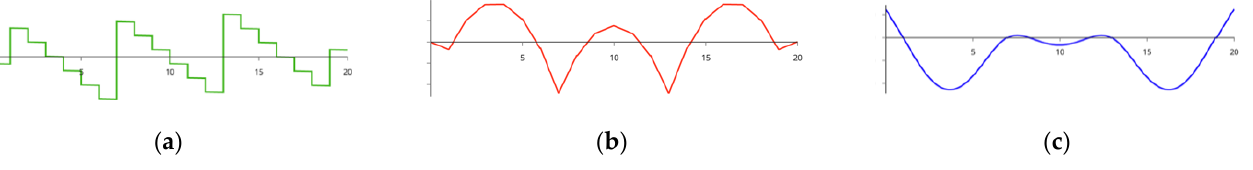
Figure A8. Two-span beam ( a ) shear force diagram, ( b ) bending moment diagram, and ( c ) deflection diagram over the beam length in m.